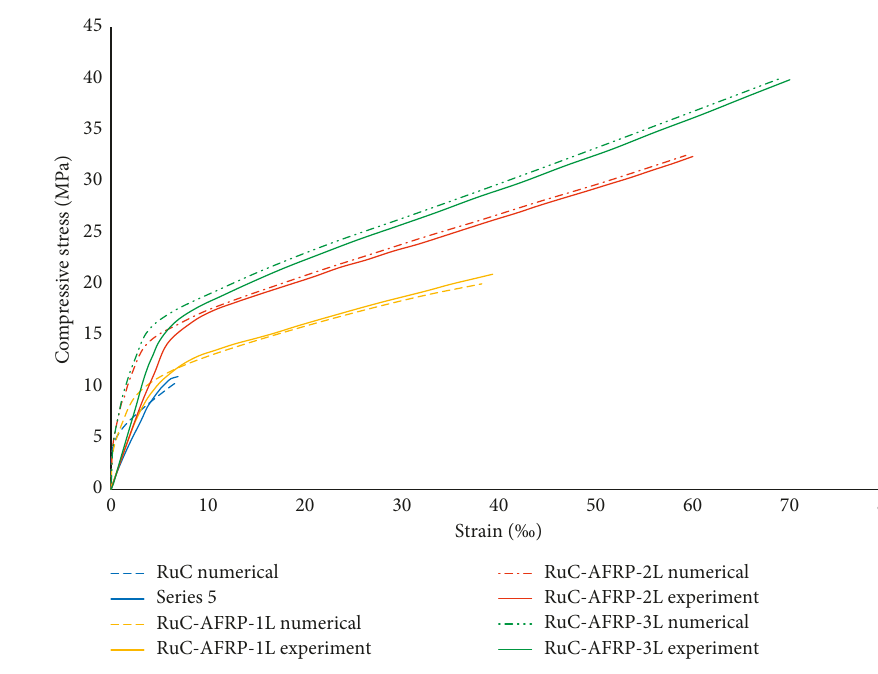
Figure 11: Numerical results vs experimental results. Table 6: Experimental vs numerical simulations